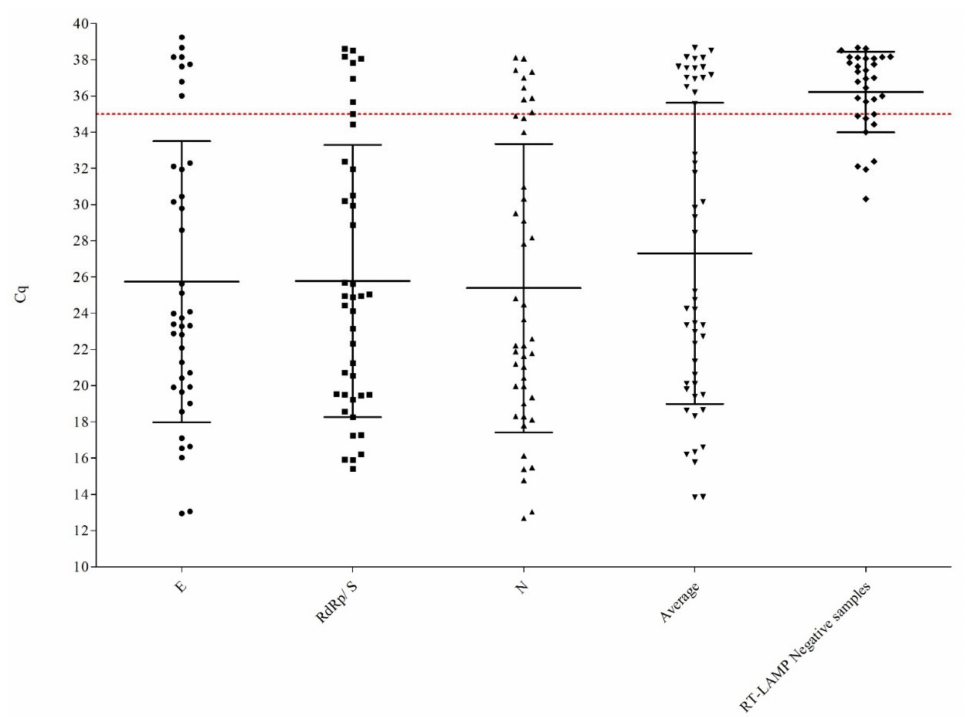
Figure 4. RT-qPCR Cq values obtained with the Allplex 2019-nCoV Assay for all the positive samples identified in this study. In each column, the average along with the standard deviation is preScheme 49. For positive samples identified by the reference RT-qPCR, 34 were positive for all the screened genes ( E , RdRp / S , and N ). One was positive for the combination E- RdRP / S , 5 for RdRP / S - N , 2 were positive for the combination E / N , and regarding samples with one single positive target by